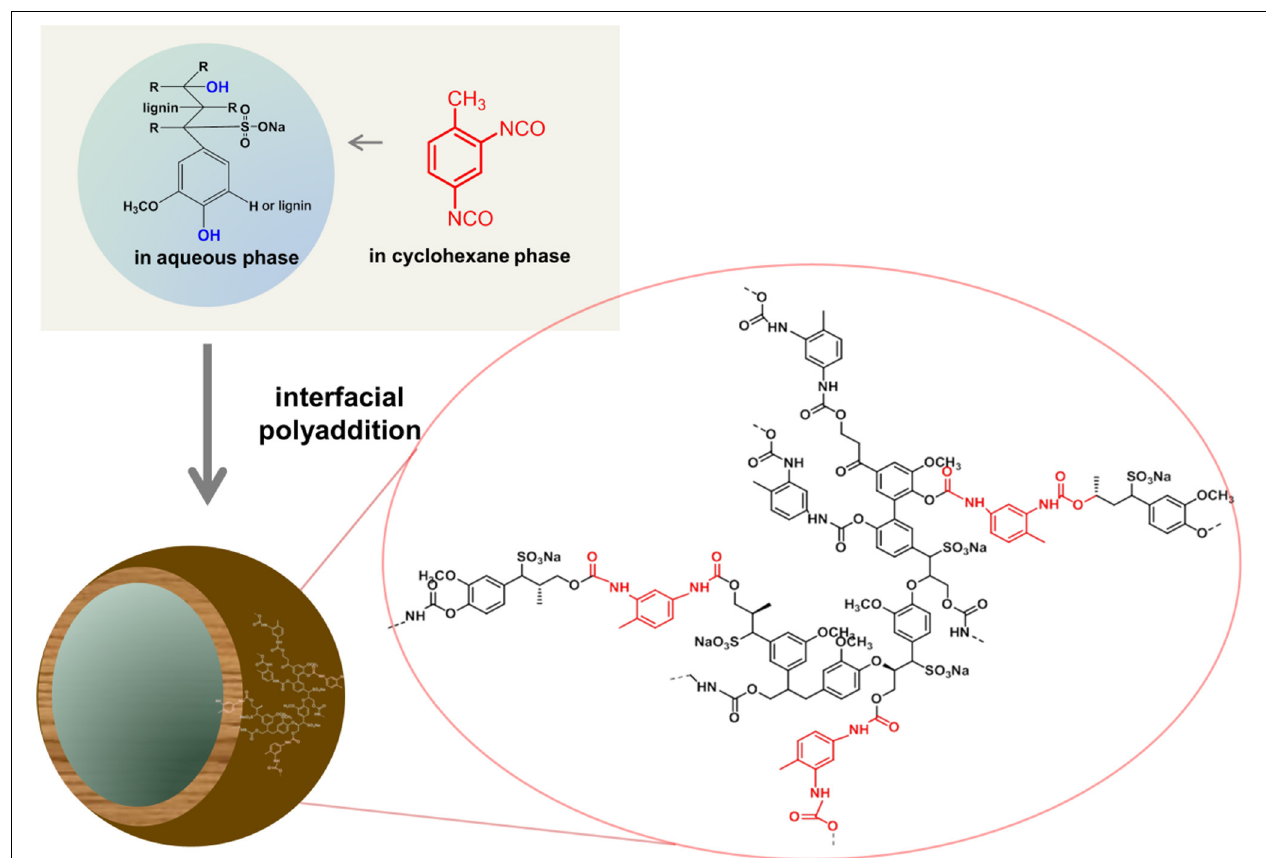
FIGURE 4 | Schematic representation for the preparation of lignin nanocapsules (image taken from Yiamsawas et al., 2014 - Published by The Royal Society of